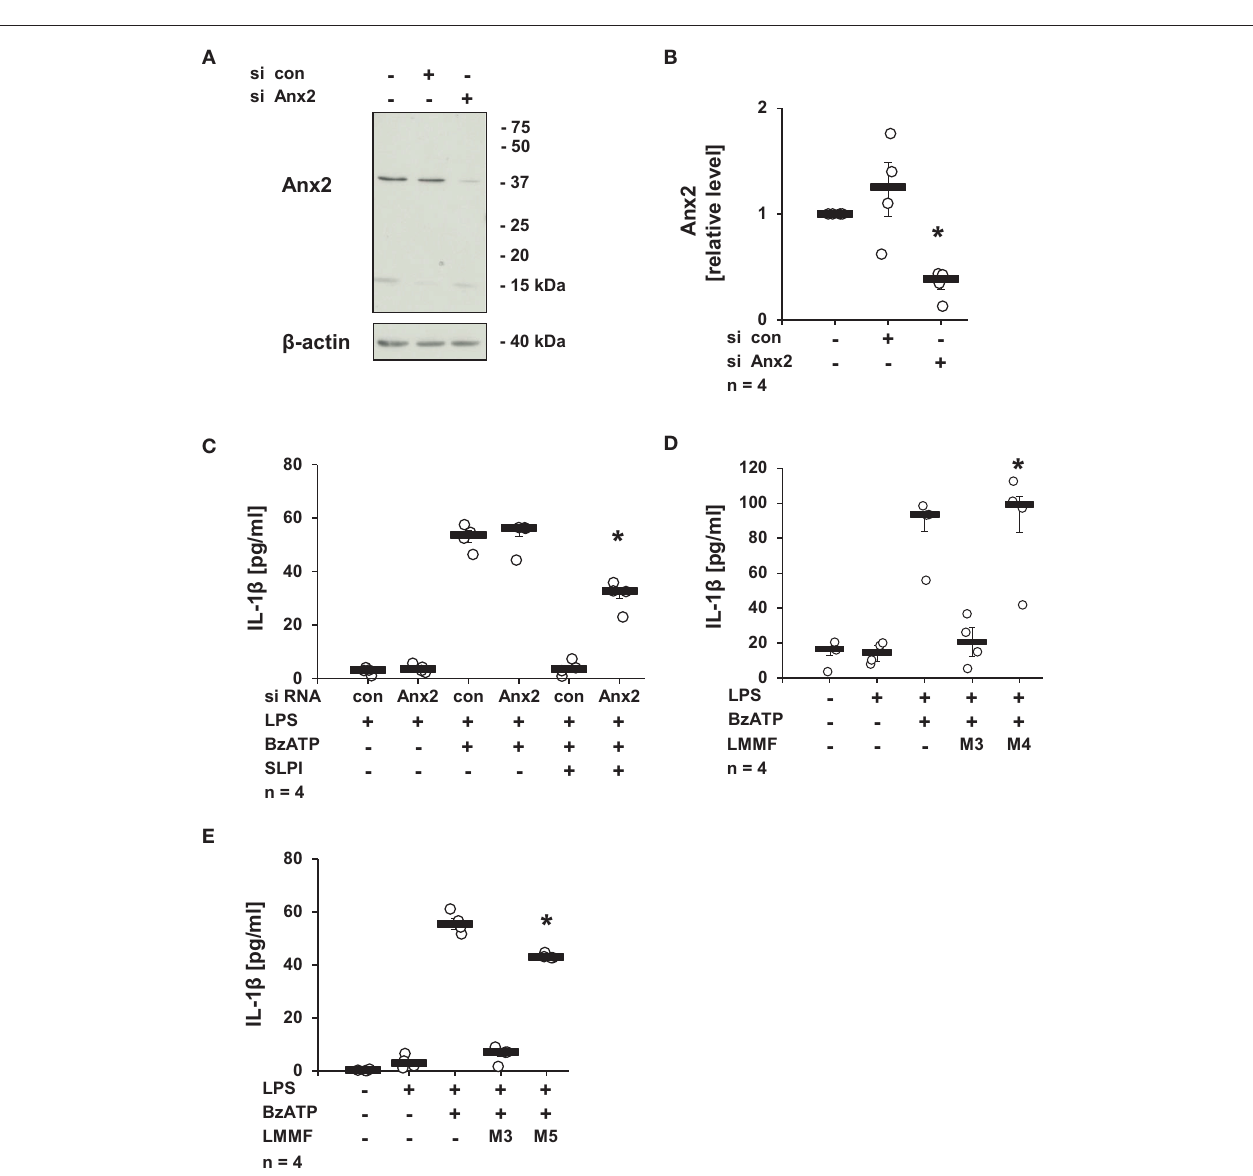
FIGURE 12 | SLPI signaling involves annexin 2 (Anx2). Expression of Anx2 in U937 cells was diminished by siRNA. Cells were primed with LPS (1 µ g/ml) for 5h and further stimulated with 2 ′ (3 ′ )-O-(4-benzoylbenzoyl)adenosine 5 ′ -triphosphate triethylammonium salt (BzATP; 100mM) for 30min in the presence or absence of SLPI (10 µ g/ml). The efficiency and specificity of the knock-down was confirmed by immunoblotting. The concentration of IL-1 β in the cell culture supernatant was measured by ELISA. (A) The protein expression level of Anx2 was silenced upon transfection with Anx2 siRNA; one representative immunoblot out of 4. (B) The optical density of the immuno-positive bands was measured and divided by the values obtained for β -actin on the same blot. The values gathered from untreated cells were set to one and all other values were calculated accordingly. * p ≤ 0.05 significantly different compared to cells transfected with control (con) siRNA. (C) Down-regulation of the expression of Anx2 siRNA blunted the SLPI-induced inhibitory effect. * p ≤ 0.05 significantly different compared to cells transfected with control siRNA (con) and stimulated with LPS, BzATP and SLPI. (D,E) Conditioned media were collected from U937 cells transfected with control siRNA (con) (M3), Anx2 siRNA (M4), or with iPLA2 β siRNA (M5). All cells were primed before media collection with LPS for 5h and SLPI was applied for additional 30min. The low molecular mass fractions (LMMF) of M4 and M5 were devoid of inhibitory activity. * p ≤ 0.05 significantly different compared to U937 cells treated with LMMF of M3. Experimental groups were compared by Kruskal-Wallis test followed by Mann-Whitney rank sum